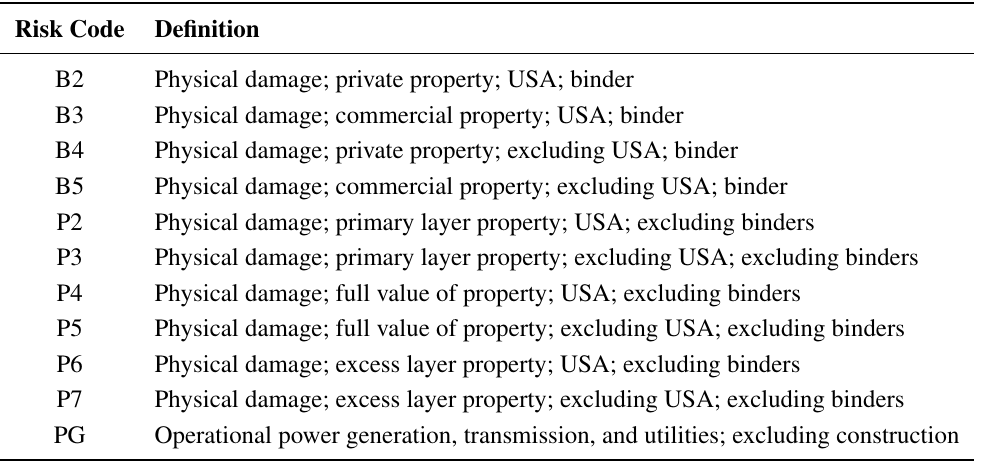
Table 2. Selection of Lloyd’s risk codes with relevant definitions.